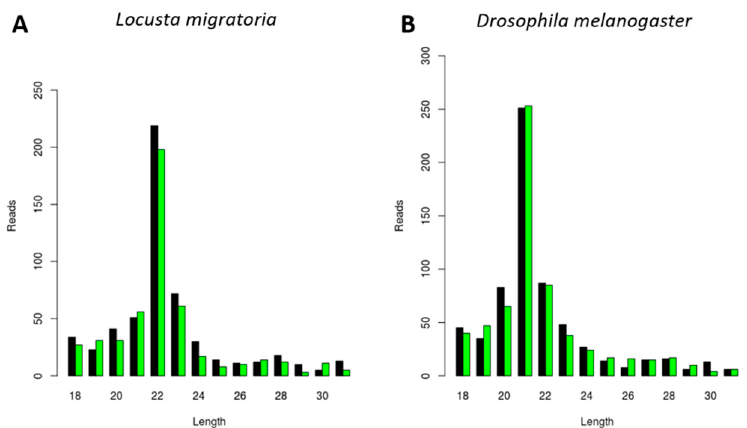
Figure 5. Generation of luciferase dsRNA (ds luc )-derived siRNAs with species-dependent length distribution. Length distribution of small RNAs mapping to the sequence of luciferase dsRNA, derived from midgut of ds luc -injected L. migratoria ( A ) and derived from D. melanogaster S2 cells treated